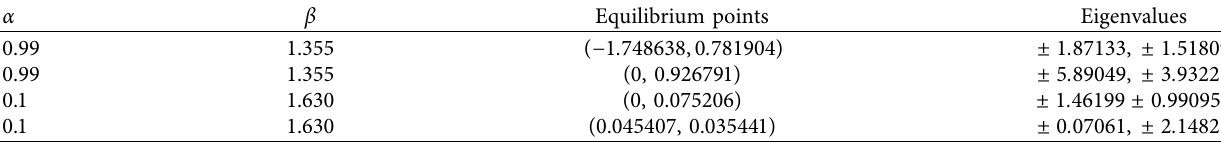
Table 4: Equilibrium points and stability analysis for case